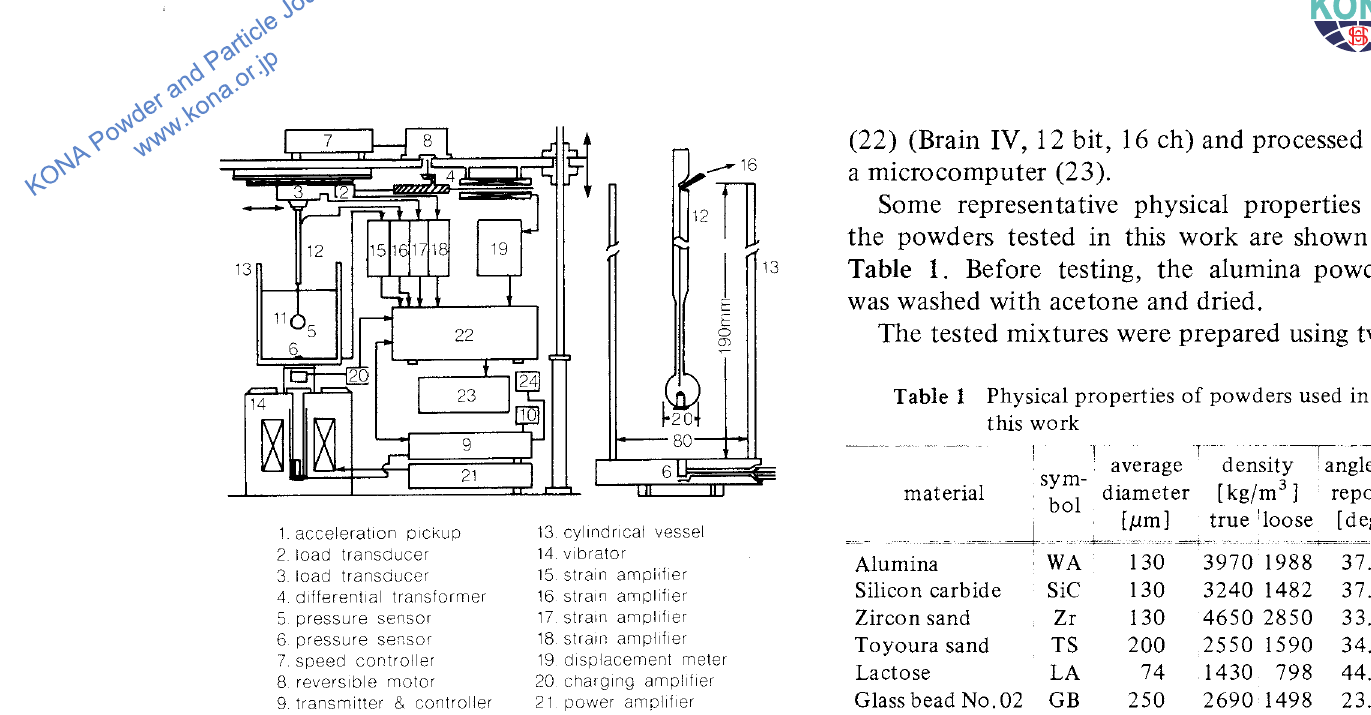
Fig. 1 Schematic diagram of the vibrational